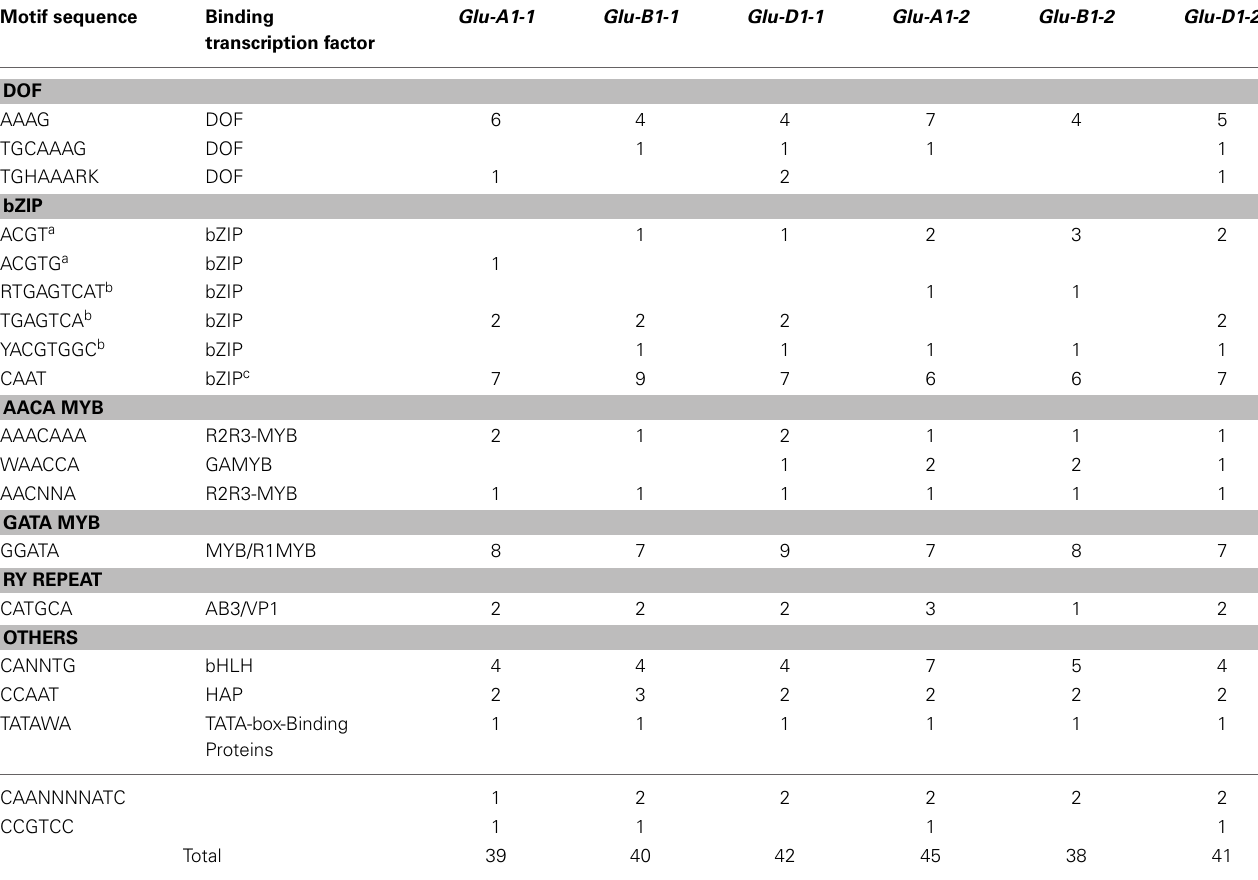
Table 6 | Number of motifs in the upstream 1000-bp region of the six HMW-GS genes from the hexaploid wheat cv. Renan. Motif